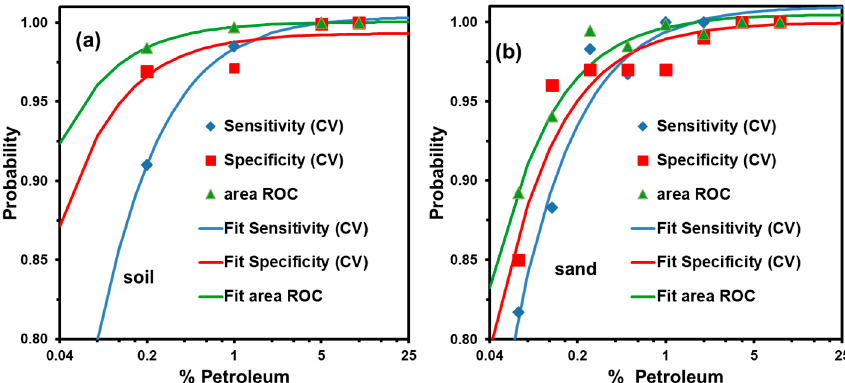
Figure 5. The PLS-DA detection probabilities for each concentration in ( a ) sand and ( b ) soil matrices. Table 1. Sensitivity, specificity, and receiver-operator curves (ROC) area for each PLS-DA model. Soil % of P